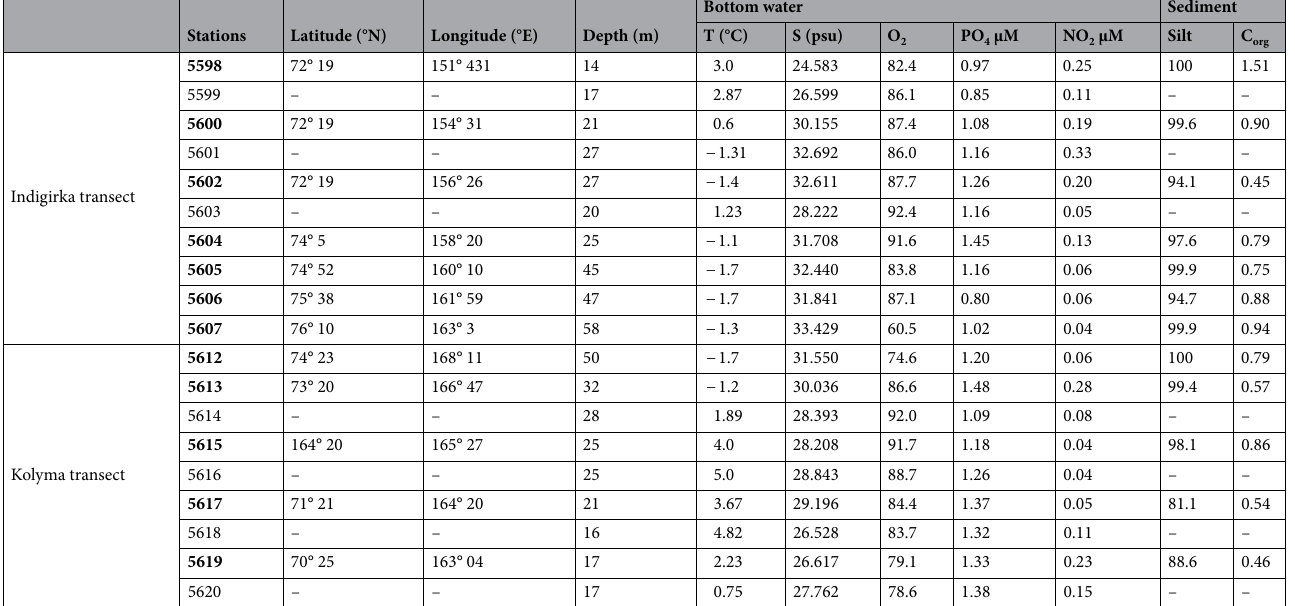
Table 5. List of sampling stations, locations, depths, and variables characterizing the near-bottom water and sediments (0–5 cm) (S—salinity, Temp—temperature, O 2 —percentage of oxygen, C org —total C org, Silt—% <50 mkm silt content. Meiobenthos stations are shown in